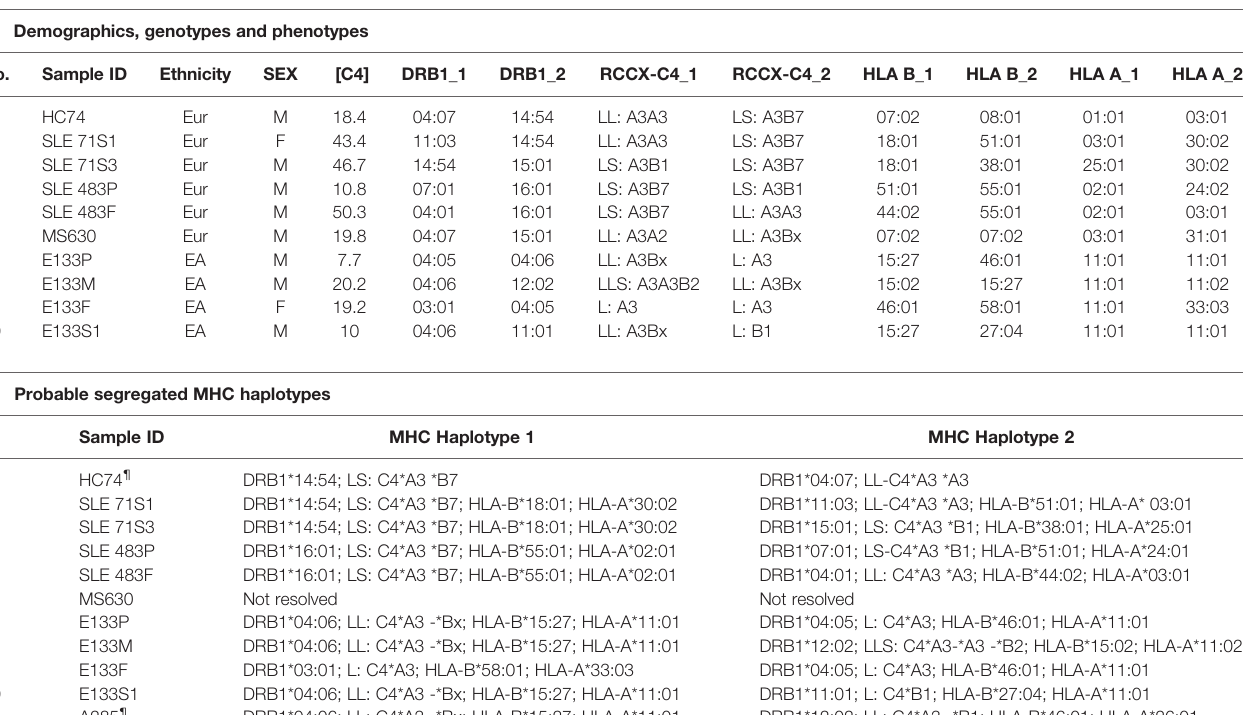
TABLE 2 | HLA, RCCX and C4 plasma protein concentrations of selected study